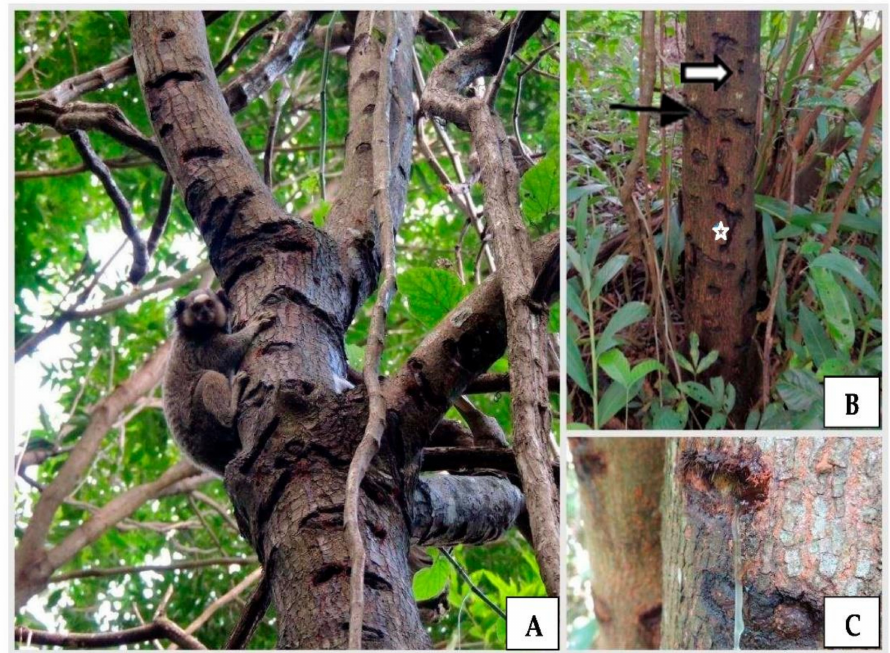
Figure 1. ( A ) Use of Tapirira guianensis tree as a source of exudate for a black-tufted marmoset ( Callithrix penicillata ). ( B ) Several orifices, with different shapes—round (white arrow), elongated (black arrow) and irregular (star)—distributed throughout the trunk. ( C ) T. guianensis